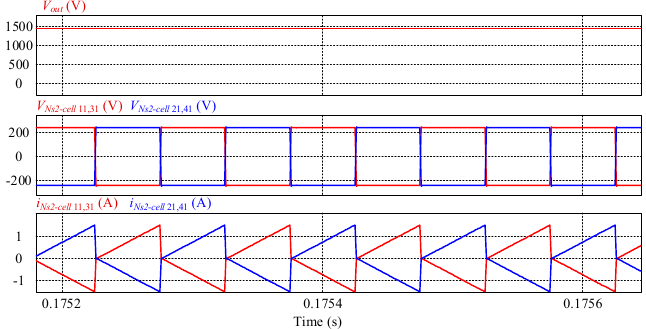
Figure 15. Zero voltage switching (ZVS) of switches in the primary circuit.